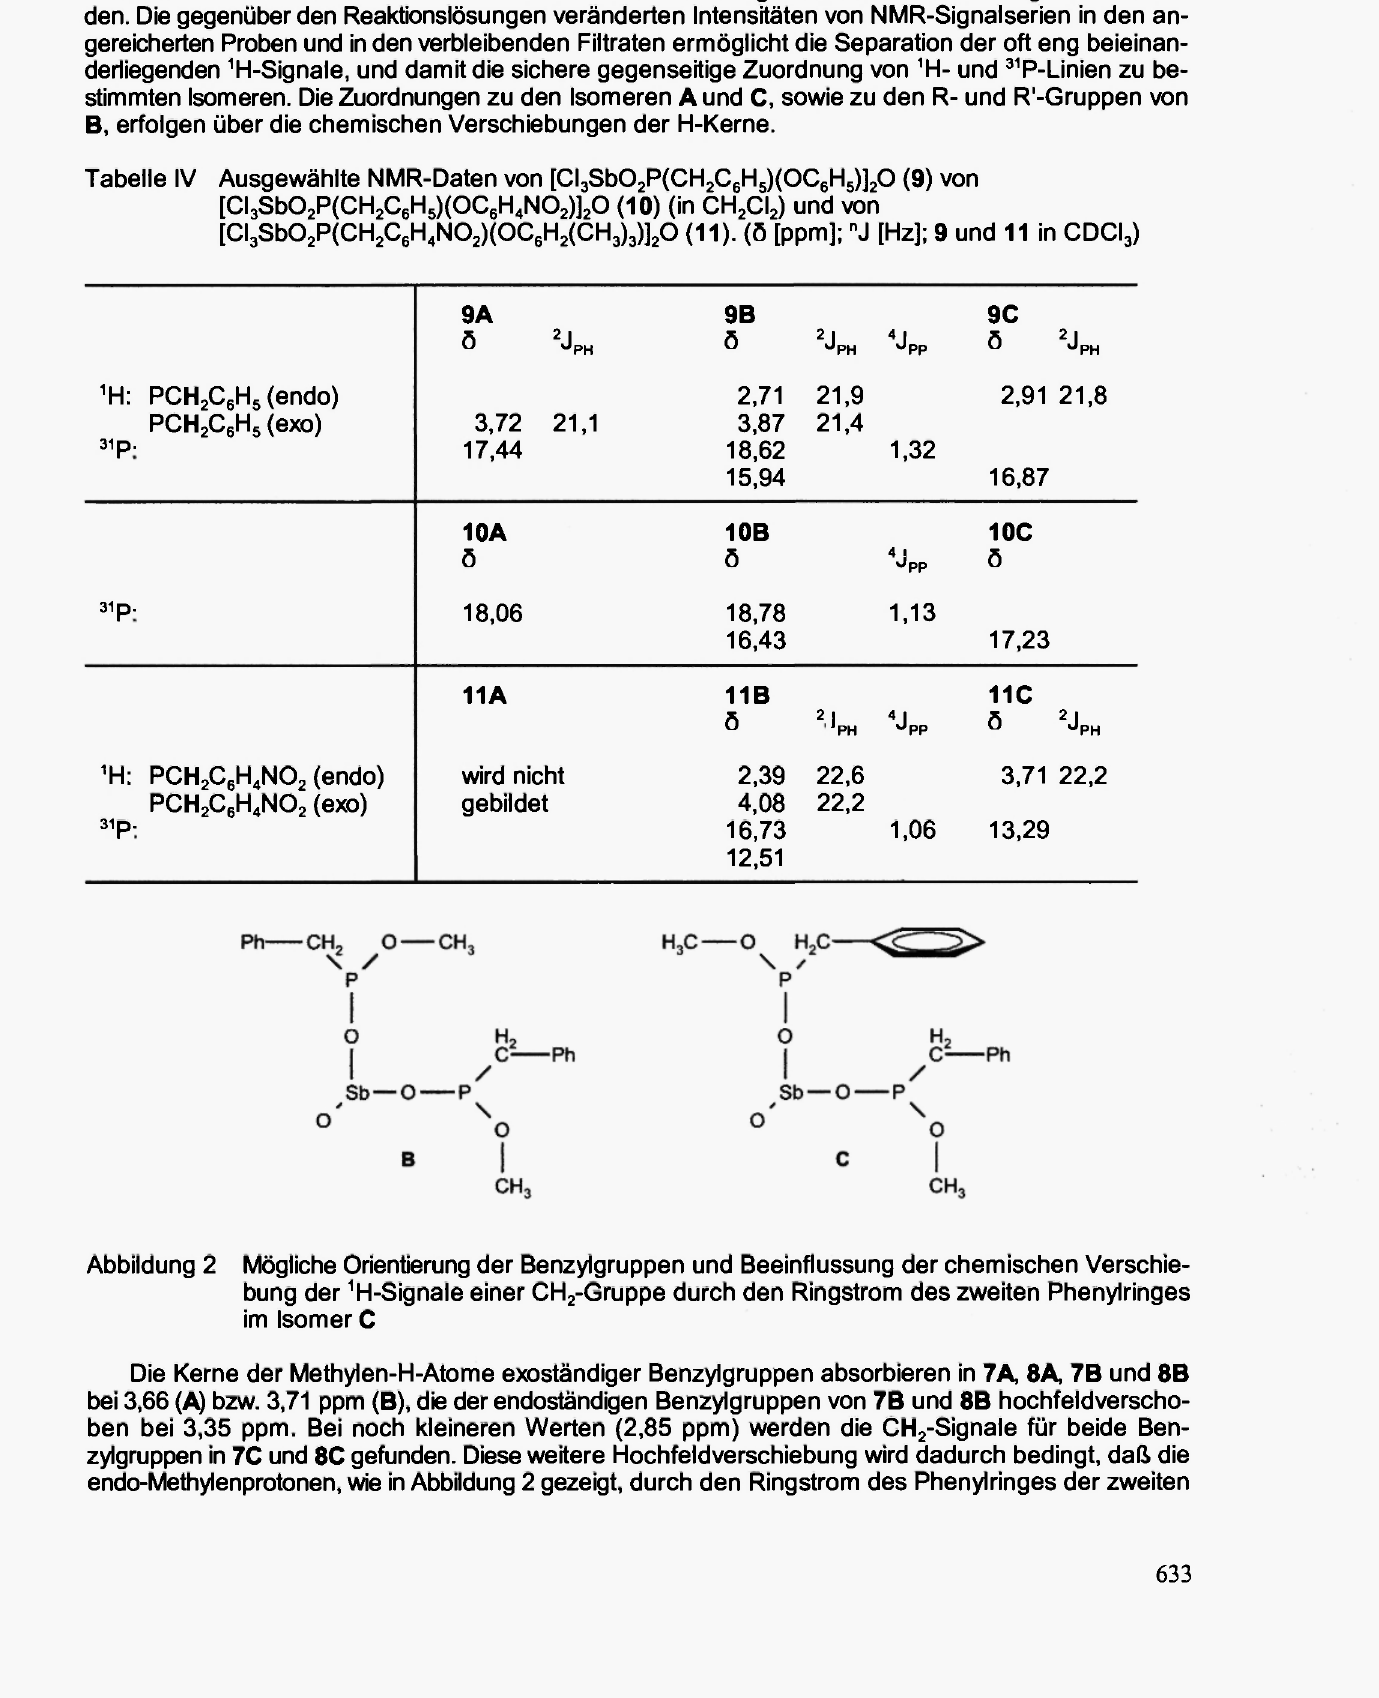
Mögliche Orientierung der Benzylgruppen und Beeinflussung der chemischen Verschie- bung der 1 H-Signale einer CH 2 -Gruppe durch den Ringstrom des zweiten Phenylringes im Isomer C Die Kerne der Methylen-H-Atome exoständiger Benzylgruppen absorbieren in 7A, 8A, 7B und 8B bei 3,66 (A) bzw. 3,71 ppm (B), die der endoständigen Benzylgruppen von 7B und 8B hochfeldverscho- ben bei 3,35 ppm. Bei noch kleineren Werten (2,85 ppm) werden die CH 2 -Signale für beide Ben- zylgruppen in 7C und 8C gefunden. Diese weitere Hochfeldverschiebung wird dadurch bedingt, daß die endo-Methylenprotonen, wie in Abbildung 2 gezeigt, durch den Ringstrom des Phenylringes der